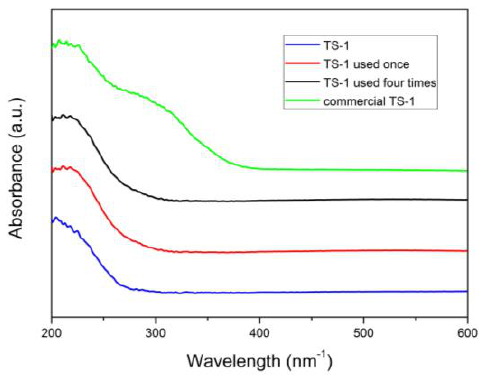
Figure 4. Diffuse reflectance (DR) UV-Vis spectra of TS-1, used TS-1, and commercial TS-1.